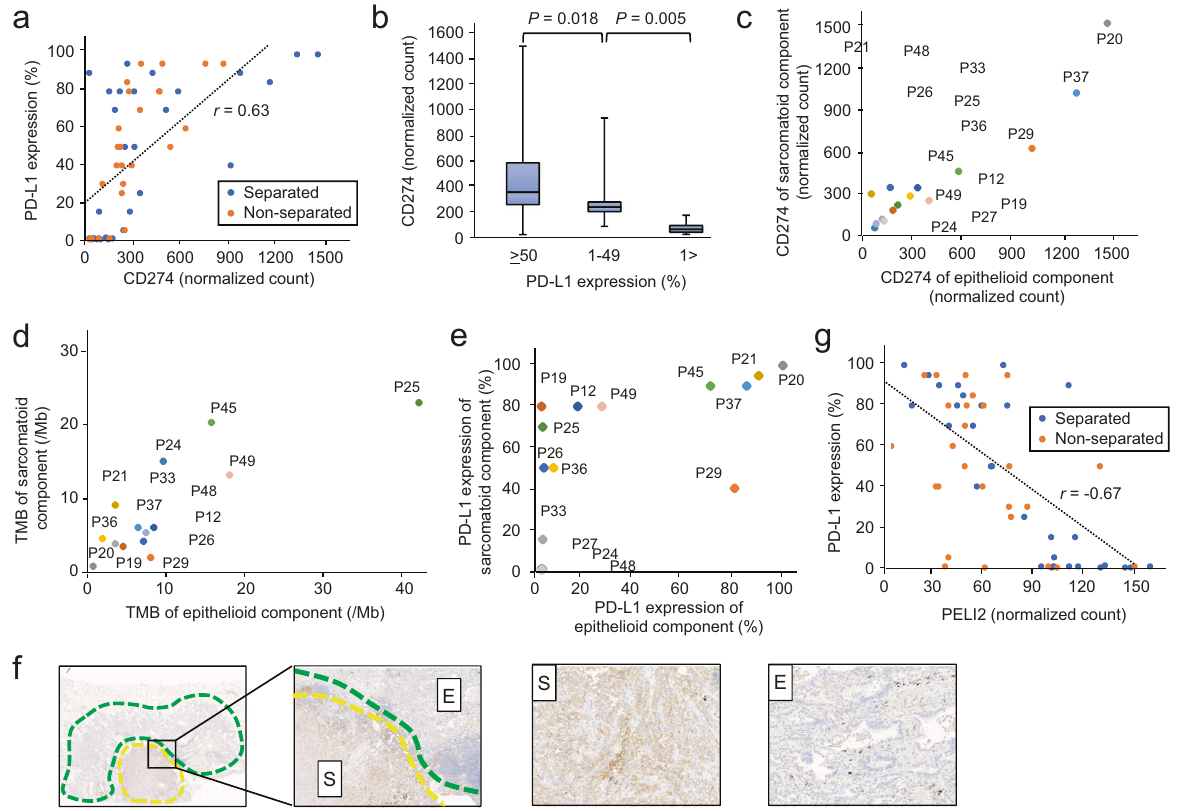
Fig. 5 Correlations among CD274 mRNA expression, tumor mutation burden (TMB), and programmed death ligand 1 (PD-L1) expression. a Normalized CD274 counts signi fi cantly correlated with the PD-L1 level (Pearson correlation coef fi cient r = 0.62; p < 0.001). Separated and unseparated samples are indicated in blue and orange, respectively. b Bar chart of the normalized CD274 counts according to PD-L1 expression. CD274 expression was signi fi cantly upregulated in the high PD-L1 expression group ( ≥ 50%). In each box, the midline represents the median, and the lower and upper boundaries represent the fi rst and third quartiles, respectively. The whiskers indicate the minimum and maximum values. c The correlation between the CD274 normalized counts in the epithelial and sarcomatoid components was evaluated. Strong correlations in the expression of CD274 were observed between the two components ( r = 0.95; p < 0.001). d The correlation between the epithelial and sarcomatoid components with TMB was evaluated. There were strong correlations of the TMB score with each of the two components ( r = 0.82; p < 0.001). e PD-L1 levels were compared between the epithelial and sarcomatoid components. Several cases exhibited higher PD-L1 expression in the sarcomatoid component compared with that of the epithelial component. f Representative images